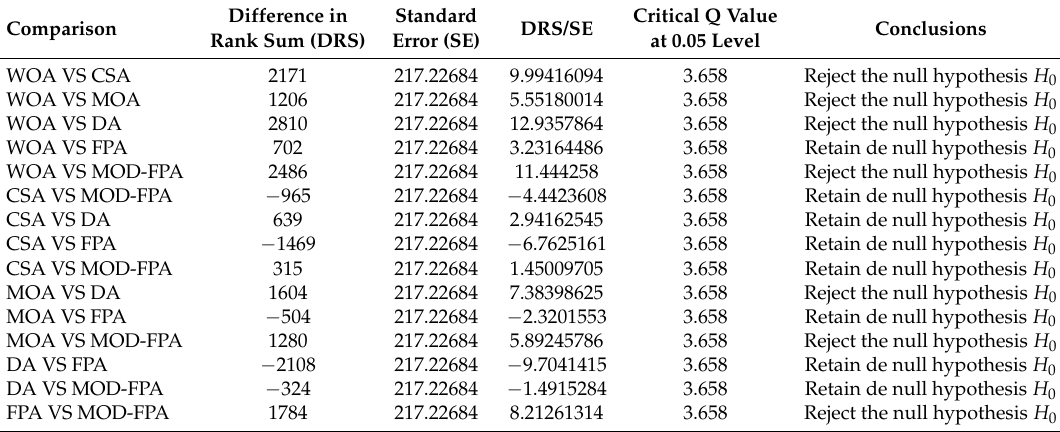
Table 17. Multiple comparisons through Nemenyi